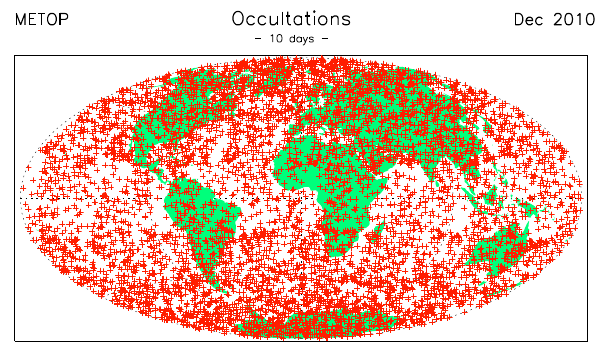
Fig. 1. Geographical distribution of occultations observed by the GRAS instrument onboard Metop-A during the first 10 days of De- cember 2010.